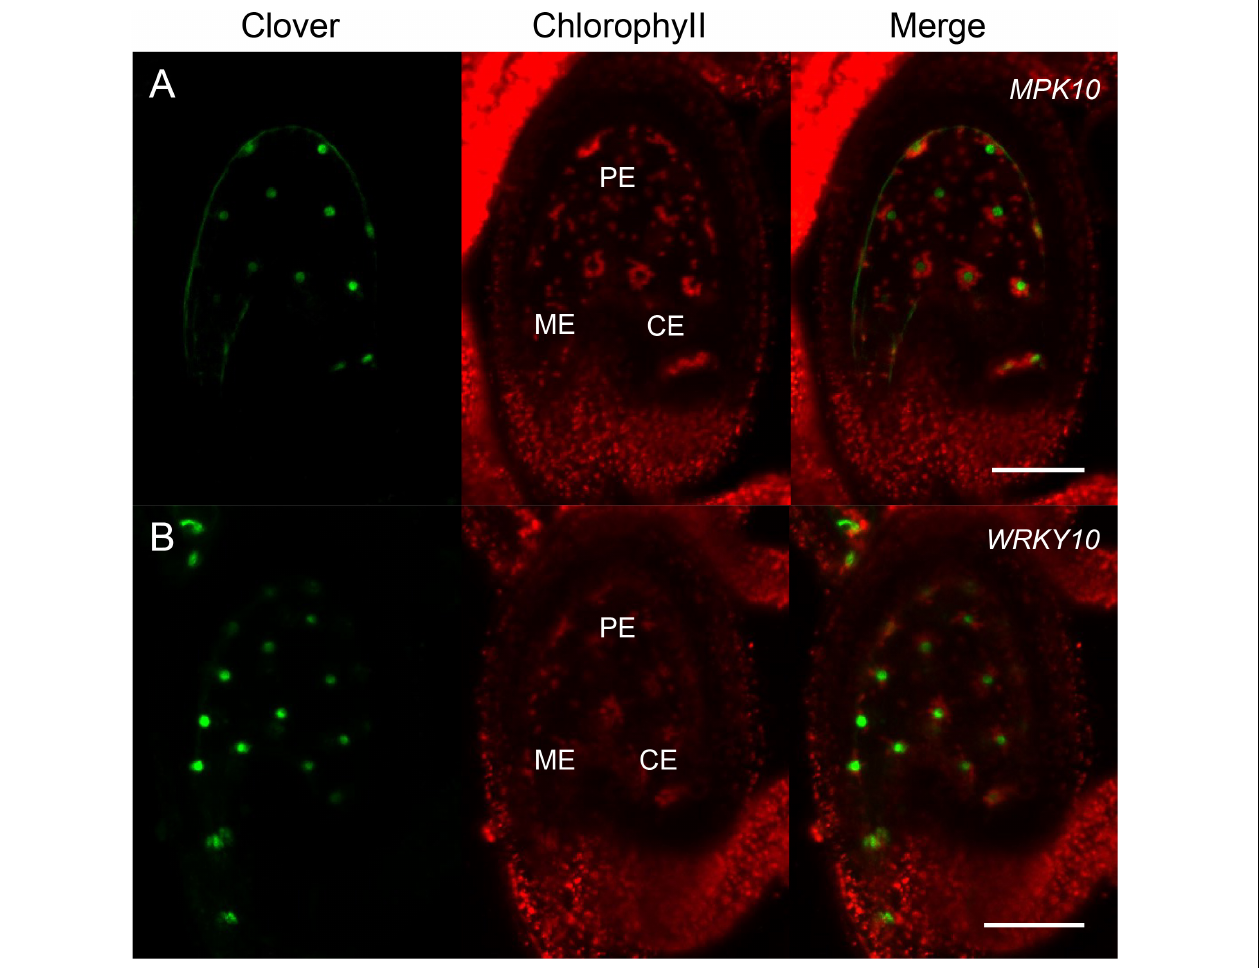
FIGURE 2 | MPK10 and WRKY10 are specifically expressed in endosperm. The expression of MPK10 and WRKY10 are shown by proMPK10: (cid:127) -H2B-Clover and proWRKY10: (cid:127) -H2B-Clover transgenic reporter lines. (A) Clover signal indicates that MPK10 is highly expressed in chalazal endosperm, and the expression level is gradually decreased along the reverse direction of micropyle-chalaza (MC) axis. (B) WRKY10 is highly expressed in micropylar endosperm, and the expression level is gradually decreased along the direction of micropyle-chalaza (MC) axis. Seeds are oriented with the micropylar pole to the left and the chalazal pole to the right. BF, bright field; ME, micropylar endosperm; PE, peripheral endosperm; CE, chalazal endosperm. Bar = 50 µ